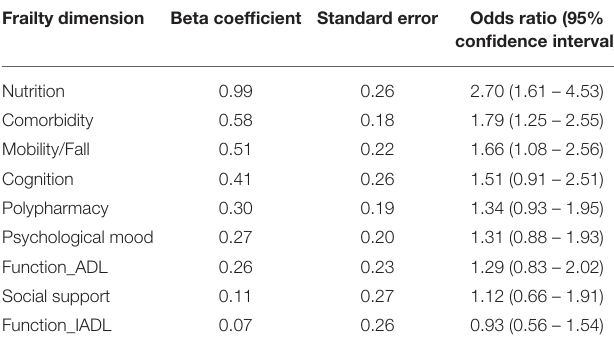
TABLE 3 | Effects of physical and mental deficits in different frailty dimensions on frailty prevalence in older cancer patients ( N = 234) using the Poisson regression analysis